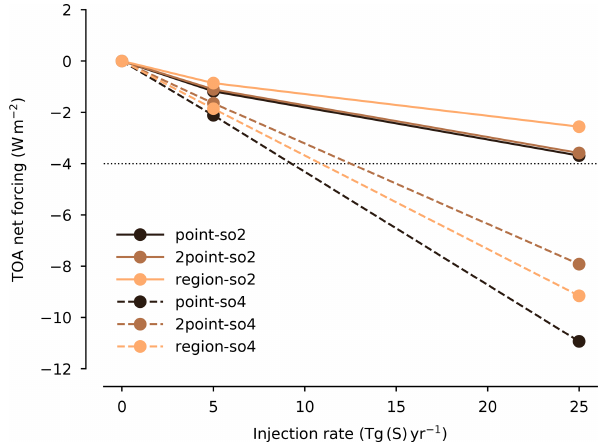
Figure 11. Global mean top-of-atmosphere (TOA) all-sky net RF exerted by artificial sulfate aerosols as a function of injection rate. The dotted black line marks a RF of − 4Wm − 2 .